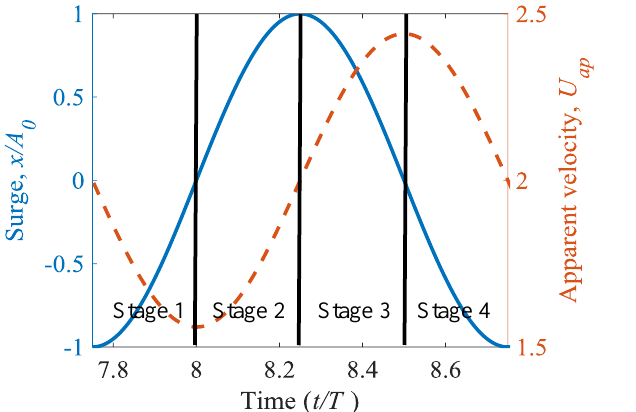
Fig. 5. Stages of the turbine in one cycle of oscillation at 𝐴 0 = 0.5m and 𝜔 0 = 0.88 rad/s.